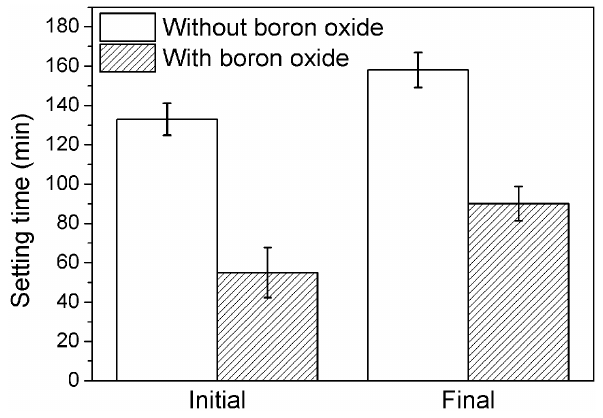
Figure 4: The initial and final setting time of cement pastes with different contents of B 2 O 3